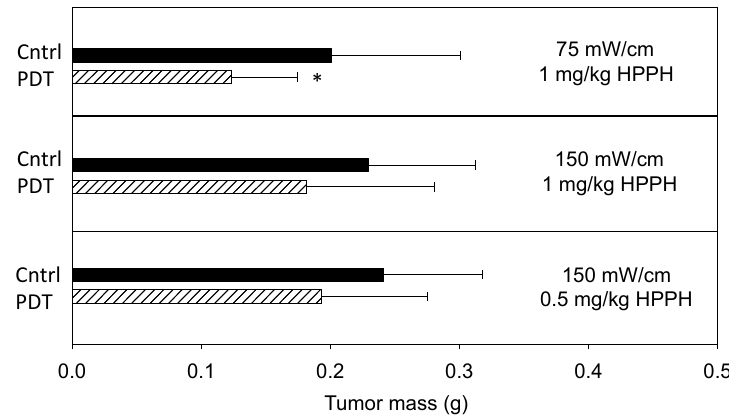
Figure 2. PDT of the thoracic cavity reduces total tumor mass. 2-(1-hexyloxyethyl)-2-devinyl pyropheophorbide-a (HPPH; Photochlor ® )-PDT at the indicated fluence rates and drug doses was delivered to the tumor-bearing murine thoracic cavity to a total dose of 50 J/cm. Tumor burden was measured 4 days after PDT. Controls (Cntrl) include animals that were untreated, received illumination (but no photosensitizer) at the fluence rate corresponding to the PDT condition, or received photosensitizer (but no illumination) at the photosensitizer dose corresponding to the PDT condition. Controls behaved similarly and were therefore pooled for analysis. Plots show the mean ± SD (error bars) for each group. n = 8–27 animals per group. * indicates p < 0.05 for comparison to control.